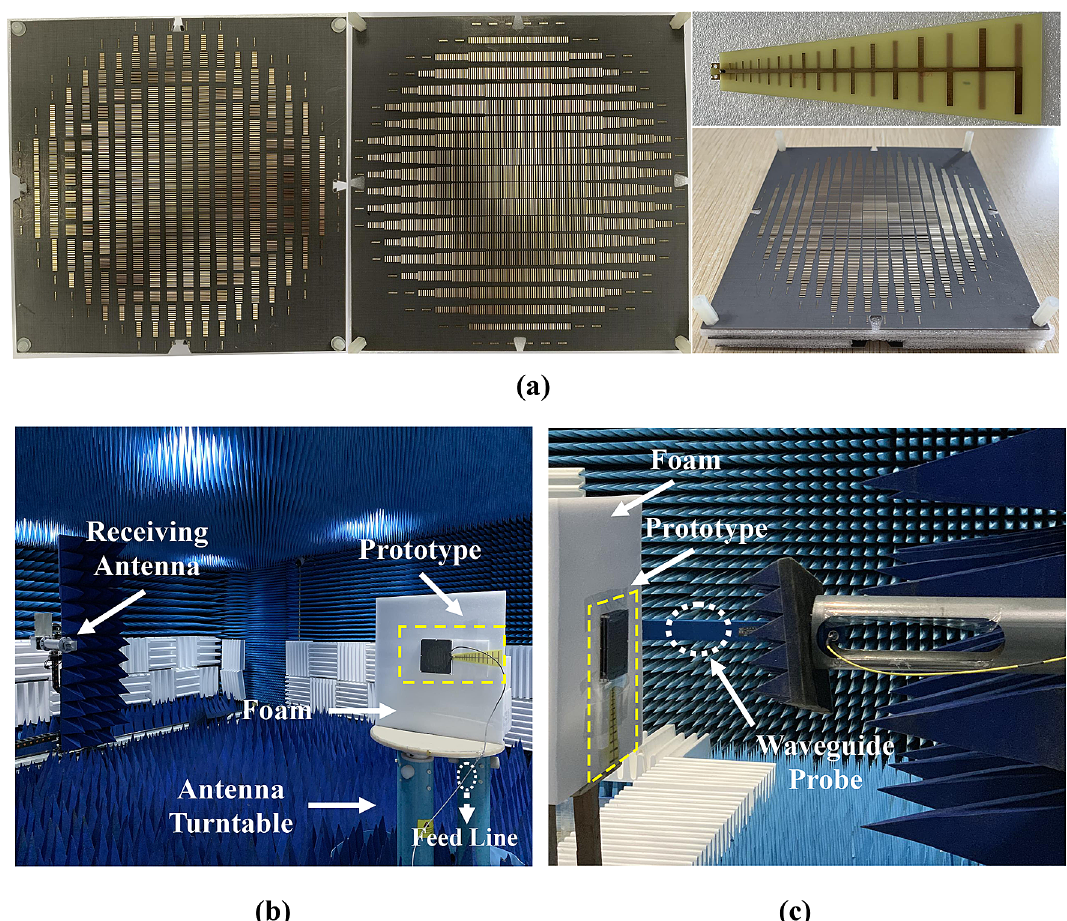
Figure 11. Photograph of the fabricated prototype and the experimental setup. ( a ) Prototypes of the Luneburg lens (top structure), the Maxwell fisheye lens (bottom structure), the feeding LPDA, and tri-layered metalens after assembly (from left to right). ( b ) Far-field setup. ( c ) Near-field